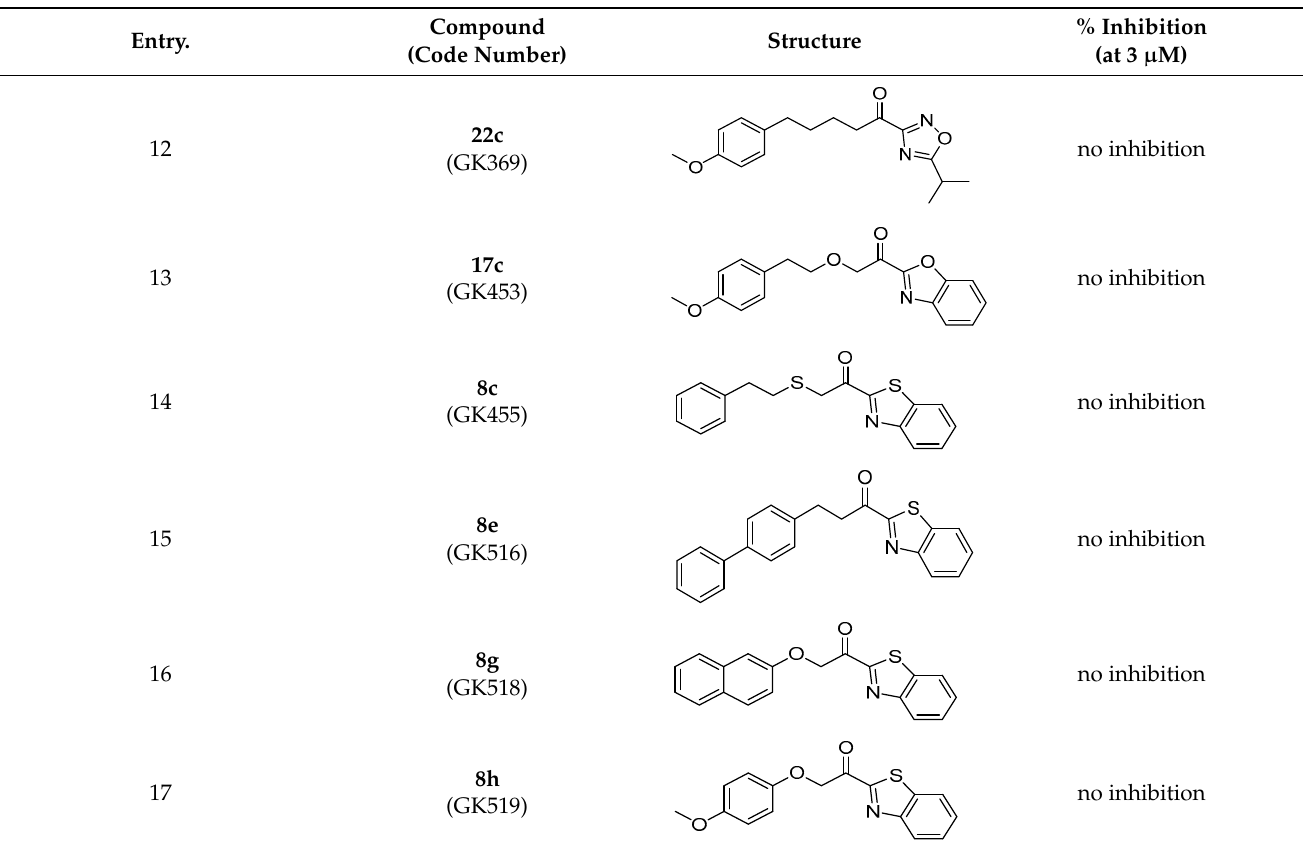
Figure 8. Effect of compounds ( A ) GK181, ( B ) GK299, and ( C ) GK491 on IL-1/Fk-stimulated PGE 2 formation in mesangial cells. Cells were pretreated for 20 min with the indicated concentrations of GK compounds and then stimulated for 24 h in the absence ( − ) or presence (+) of 1 nM interleukin 1 β (IL-1) plus 5 µM forskolin (Fk). Supernatants were taken for PGE 2 quantification using an en- zyme-linked immunoassay as described in the Methods section. Data are presented as % of maxi- mal IL-1/Fk stimulation and are means S.D. ( n = 3). *** p < 0.001 considered statistically significant when compared to the unstimulated samples; # p < 0.05, ## p < 0.01, ### p < 0.001 compared to the IL- 1/Fk-stimulated samples.